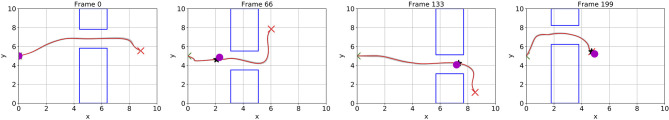
The magenta point particle has to move from the start position (green ×) to the target position (red ×) without hitting the walls (blue rectangles). The position of the hole in the wall and the target position change with time. As these positions change, our learning system computes the corresponding trajectory distributions on the fly to solve this task. The red line corresponds to the mean of the computed trajectory distribution. The light gray trajectories are samples from the computed distribution. The black star-shaped marker moves forward along the mean of the current distribution. The magenta point particle tracks the black star-shaped marker with a PD controller. This figure depicts four frames of a test case.